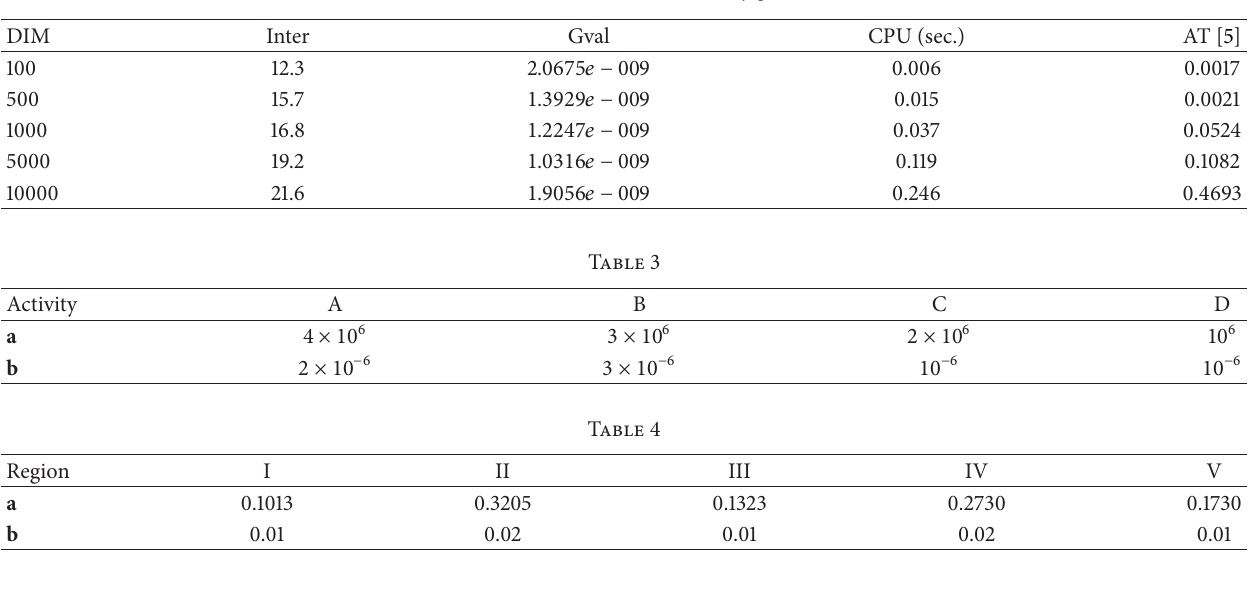
Table 2: Problem (1) with with a , b ,𝑐 randomly generated in [0, 1]